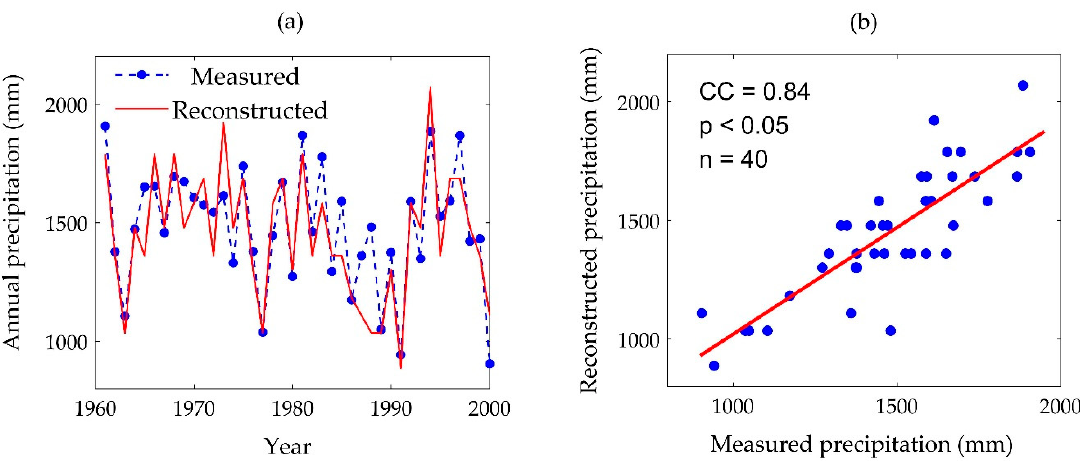
Figure 5. Comparison of reconstructed precipitation and measured precipitation through ( a ) line chart and ( b ) scatter plot in Wuzhou City from 1961 to 2000.